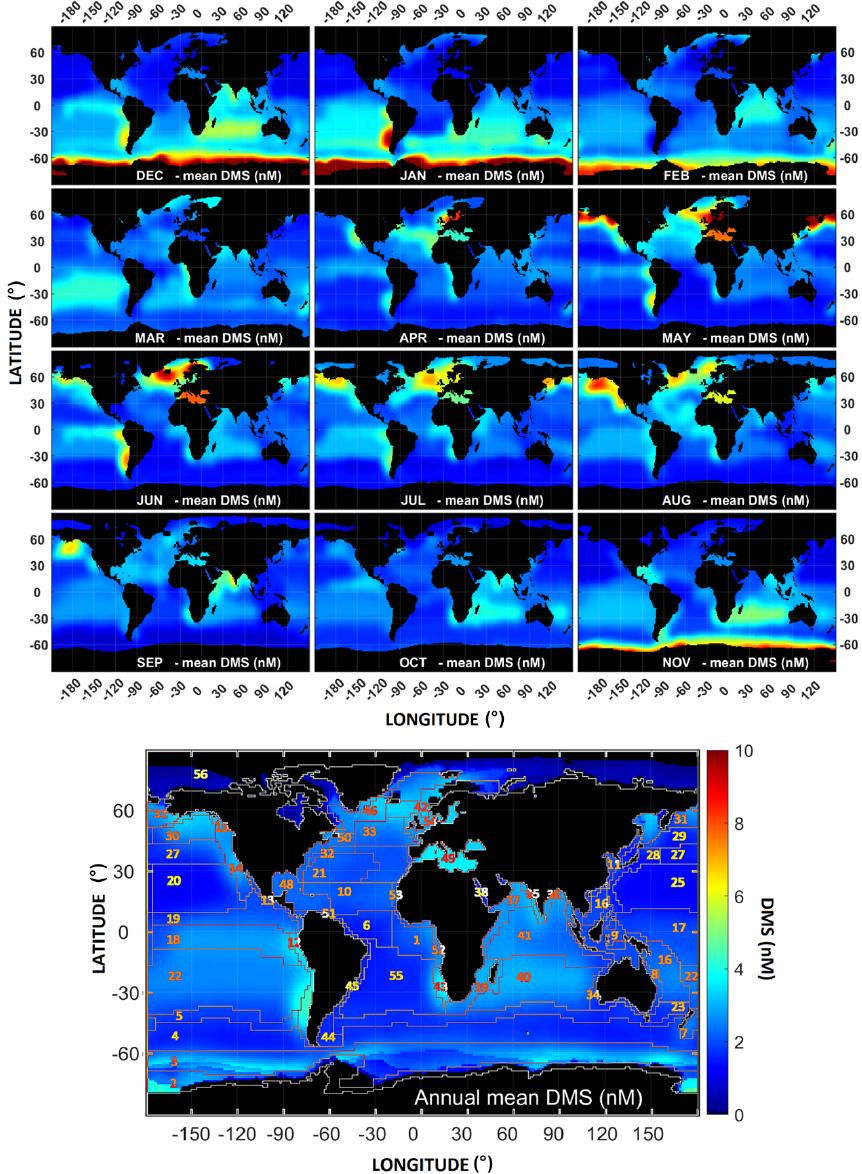
Figure 6. Distribution of the monthly and annual DMS concentrations as estimated by DMS-Rev3 climatology with a 50% sea-ice